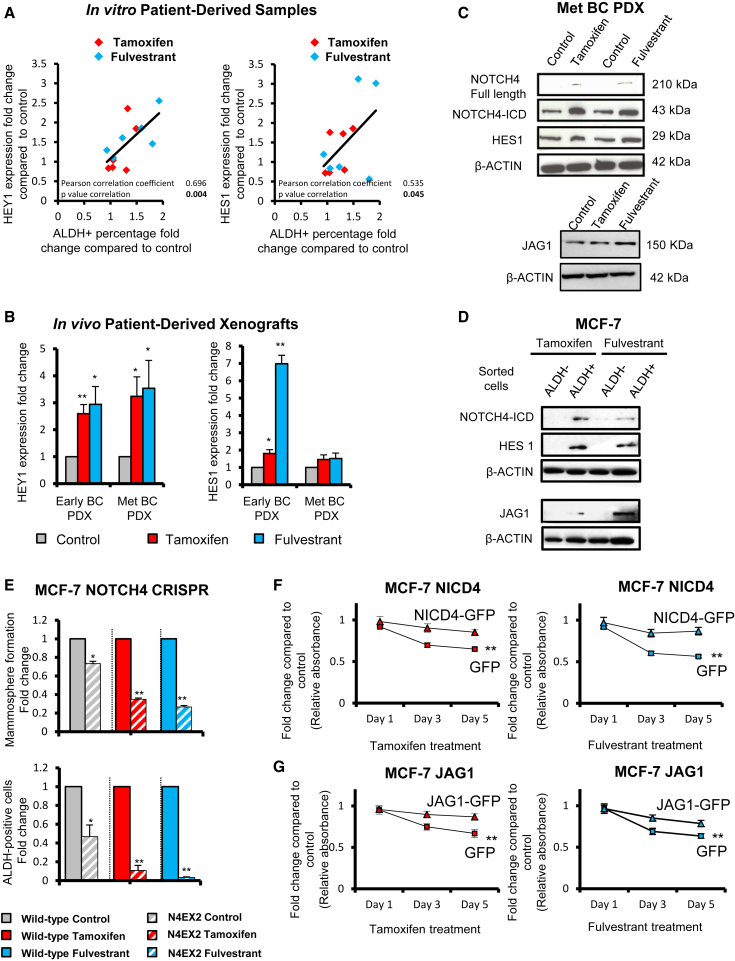
Tamoxifen or Fulvestrant Treatment Upregulates Notch Target Genes in Patient-Derived Samples and PDXsJAG1-NOTCH4 receptor signaling in ALDH-positive cells drives Notch activity in endocrine-resistant BC.(A and B) Expression of Notch target genes HEY1 and HES1 was assessed by real-time qPCR analysis and compared to control to determine fold change. (A) Metastatic BC patient-derived cells were treated for 7–9 days with ethanol (control), tamoxifen (10−6 M), or fulvestrant (10−7 M) and a correlation between fold change of expression of HEY1 and HES1 and fold change of percentage of ALDH-positive cells is shown. (B) Early (HBCx34) and metastatic (BB3RC31) BC PDXs: the effect of in vivo treatment for 14 days with tamoxifen (10 mg/kg/day, oral gavage) or fulvestrant (200 mg/kg/week, subcutaneous injection) on HEY1 and HES1.(C) NOTCH4, HES1, and JAG1 protein expression levels determined by western blot in metastatic (Met) (BB3RC31) BC PDX. β-actin was used as a reference for the loading control.(D) NOTCH4, HES1, and JAG1 protein expression levels were determined by western blot in MCF-7 ALDH-negative and ALDH-positive sorted cells. MCF-7 cells were treated with tamoxifen or fulvestrant for 6 days before ALDH sorting.(E) Wild-type MCF-7 cells (filled bars) and a CRISPR clone containing a disruption of NOTCH4 exon 2 (N4EX2 cells, hatched bars) treated in adherence with ethanol (Control, gray bars), 10−6 M tamoxifen (red bars), and 10−7 M fulvestrant (blue bars) for 6 days. N4EX2 cells’ fold change of MFE and ALDH-positive cells after treatments was compared to that of the wild-type cells.(F and G) NICD4 and JAG1 rescue tamoxifen- or fulvestrant-inhibited growth: cell number (using sulforhodamine B [SRB] assay, y axis) of MCF-7 overexpressing (F) NICD4-GFP, (G) JAG1-GFP, or GFP control incubated with tamoxifen or fulvestrant for 1, 3, and 5 days (x axis) compared to the respective cell line treated with control ethanol. p values are for the 5-day treatment.Data are represented as mean ± SEM. ∗p < 0.05; ∗∗p < 0.01.See also Figures S2 and S4.